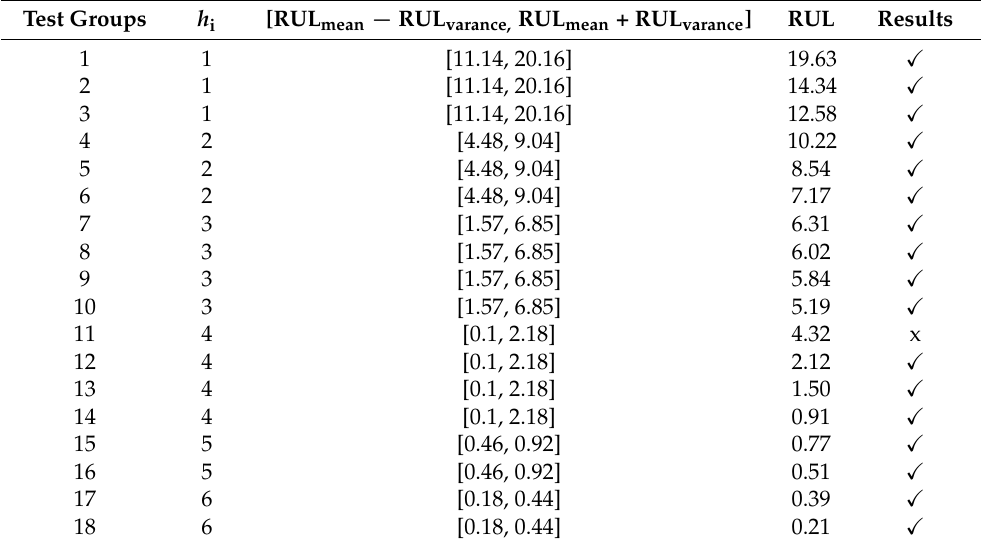
Table 4. The result of residual life